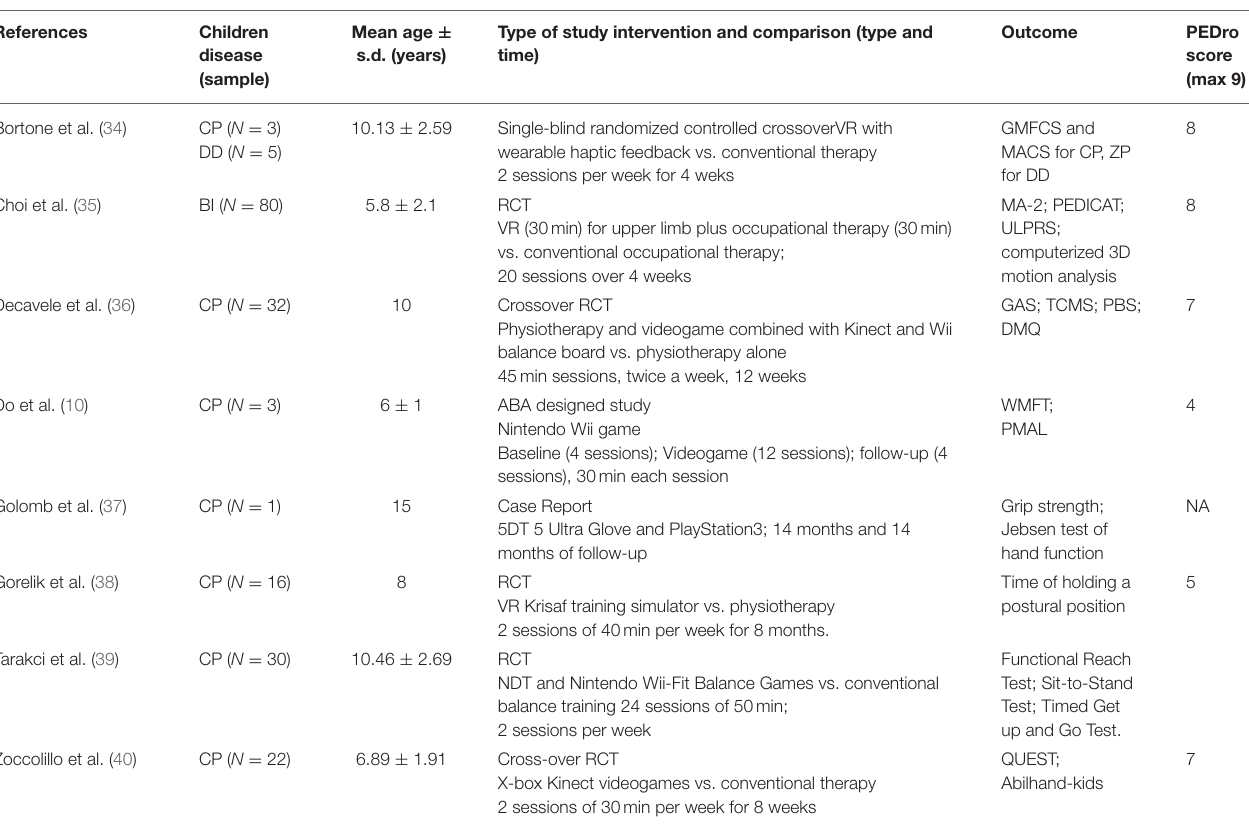
TABLE 1 | The longitudinal studies entered in this